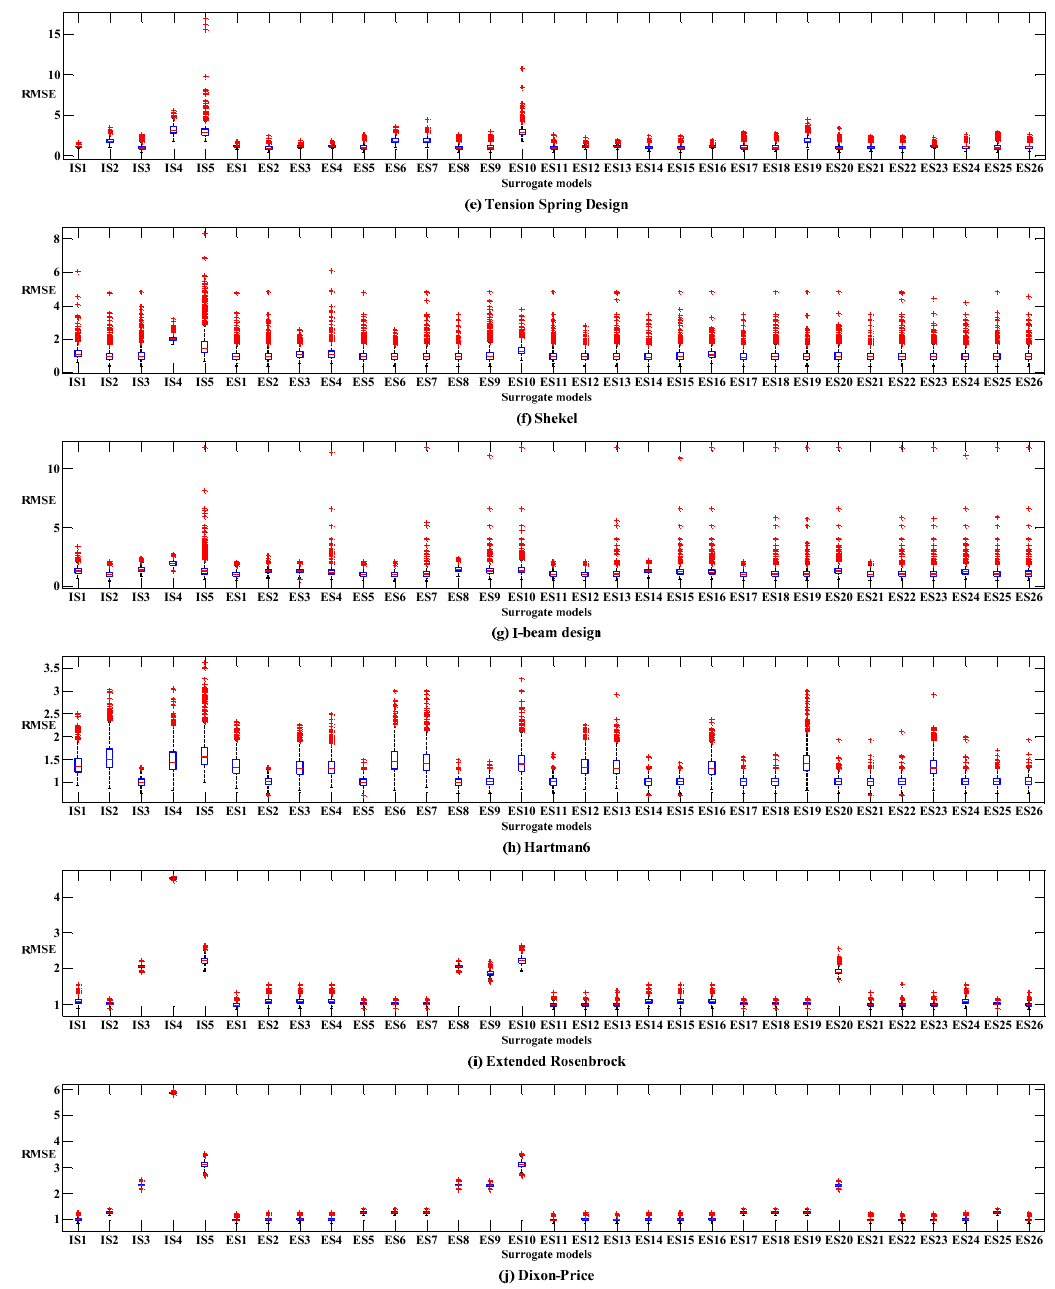
Figure 4. Boxplots of RMSE for all test problems.